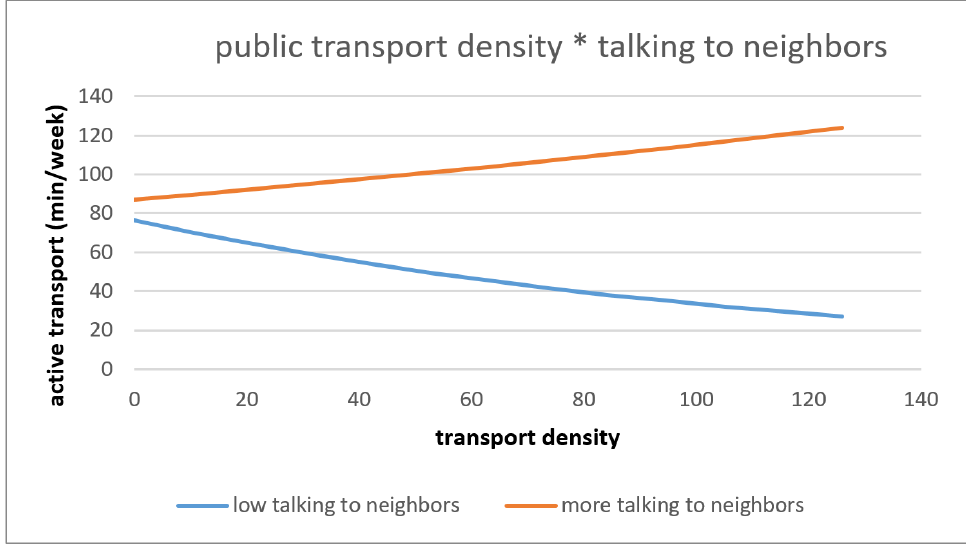
Figure 4. Interaction effect of public transport density and talking to neighbors on active transport.